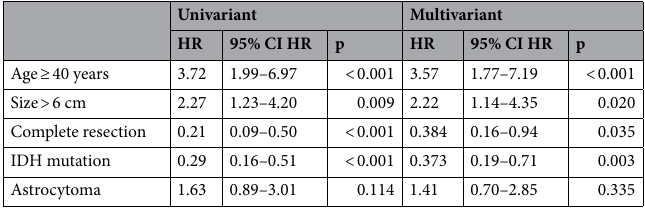
Table 4. Prognostic factor univariant and multivariant analysis.